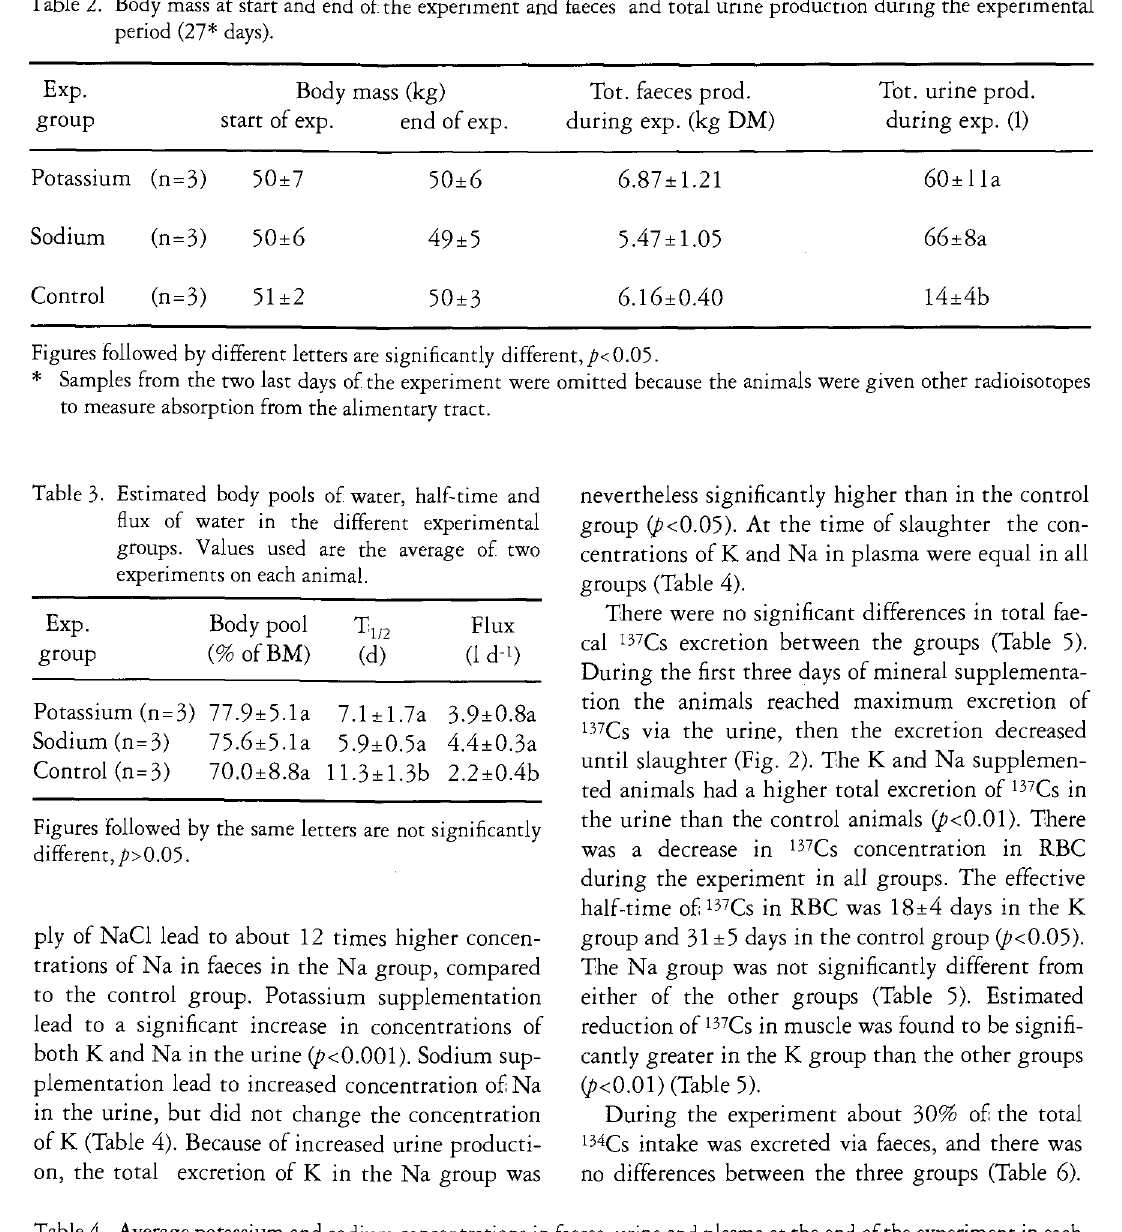
Table 2. Body mass at start and end of the experiment and faeces and total urine production during the experimental period (27* days).